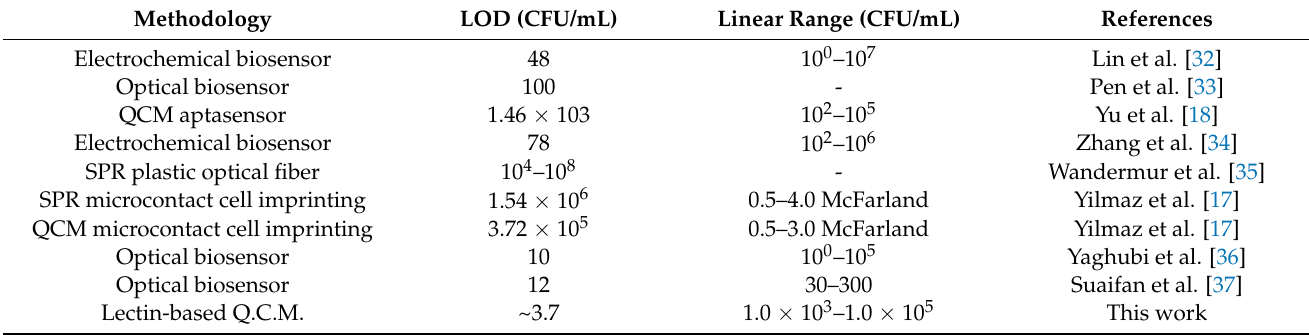
Figure 6. Calibration curve for 4—NMBA ligand and 4—TNM ligand. N = 3 with standard deviations of 0.023 and 0.118, respectively. Table 2. Comparative analysis of mannose-derived QCM biosensor to other